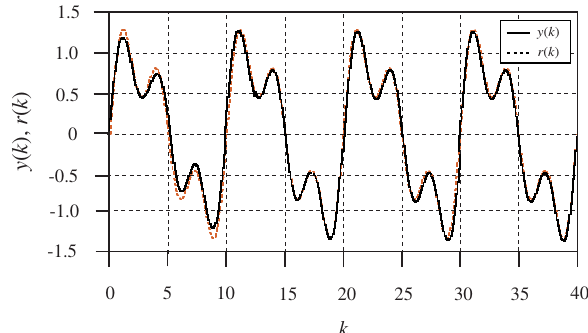
Figure 8. The reference signal and the output of the system with no preview.